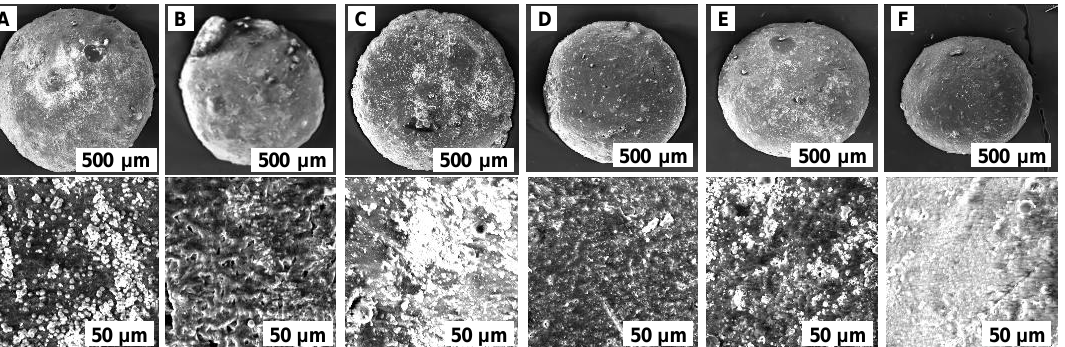
Figure 3. SEM photographs of CSCH beads before dye adsorption ( A ) and after adsorption of AR ( B ), RB ( C ), 25% AR + 75% RB ( D ), 50% AR + 50% RB ( E ), and 75% AR + 25% RB ( F ).